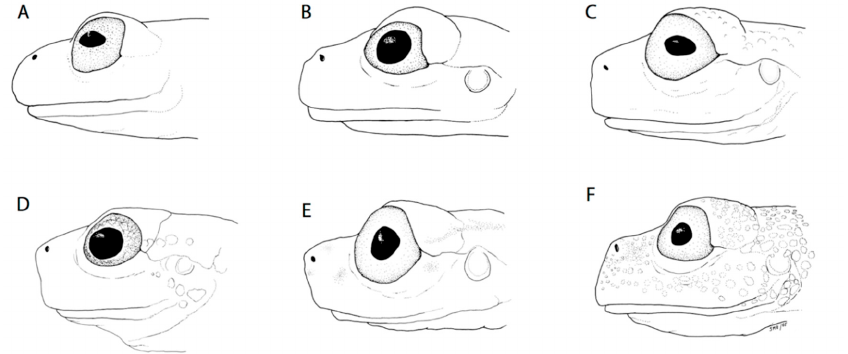
Figure 10. Snout shape in Glassfrogs. ( A ) Round, Hyalinobatrachium munozorum , KU 118054. ( B ) Bluntly round, Centrolene ballux , KU 164725. ( C ) Truncate, Nymphargus megacheirus , KU 143269. ( D ) Slightly protruding, “Centrolene” medemi , KU 164493. ( E ) Protruding, “Cochranella” balionota , KU 164708. ( F ) Sloping, Nymphargus grandisonae , KU 164688. Drawings by Juan M. Guayasamin. Morphometrics —morphological variables were measured with digital callipers to the nearest 0.1 mm, as follows: (1) Snout–vent length (SVL) = distance from tip of snout to posterior margin of vent; (2) tibia length (TL) = length of flexed leg from knee to heel; (3) foot length (FL) = distance from proximal margin of outer metatarsal tubercle to tip of Toe IV; (4) head length (HL) = distance from tip of snout to posterior angle of jaw articulation; (5) head width (HW) = width of head measured at level of jaw articulations; (6) interorbital distance (IOD) = distance between upper eyelids, representing the width of the underlying frontoparietals; (7) upper eyelid width (UE) = greatest transverse width of upper eyelid; (8) internarial distance (IN) = distance between nostrils; (9) eye–nostril distance (EN) = distance from posterior margin of nostril to anterior margin of eye; (10) snout– eye distance (SE) = distance from tip of snout to anterior margin of eye; (11) horizontal eye diameter (ED) = distance between anterior and posterior borders of eye; (12) tympanum diameter (TD) = distance between anterior and posterior margins of tympanic annulus; (13) eye–tympanum distance (ET) = distance from posterior border of eye to anterior margin of tympanic annulus; (14) radio–ulna length (RUL) = length of flexed forearm from elbow to proximal border of palmar tubercle; (15) hand length (HDL) = distance from the proximal margin of palmar tubercle to tip of Finger III; (16) Finger-I length (F1L) = distance from outer margin of palmar tubercle to tip of Finger I; (17) Finger-II length (F2L) = distance from outer margin of palmar tubercle to tip of Finger II; (18) disc of Finger III (3DW) = greatest width of disc of Finger III; and (19) Finger-III width (F3W) = width of Finger III measured at the level of distal subarticular tubercle, including lateral fringes and excluding webbing. For comparing different body sizes (SVL) among glassfrogs, we considered the average size of males and categorized them according to the following criteria: Minute (SVL < 22 mm), small (SVL 22–25 mm), medium (SVL 25–30 mm), large (SVL 30–50 mm), and giant (SVL > 50). Eye diameter was divided into small (eye diameter < 10% SVL), moderate size (eye diameter 10%–15% SVL), and large (eye diameter > 15% SVL). Tympanum was considered to be very small (tympanum < 20% of eye diameter), small (tympanum 20%–30% of eye diameter), moderate (tympanum 31%–40% of eye diameter), large (tympanum diameter 41%–50% of eye diameter), and very large (tympanum diameter > 50% of eye diameter.